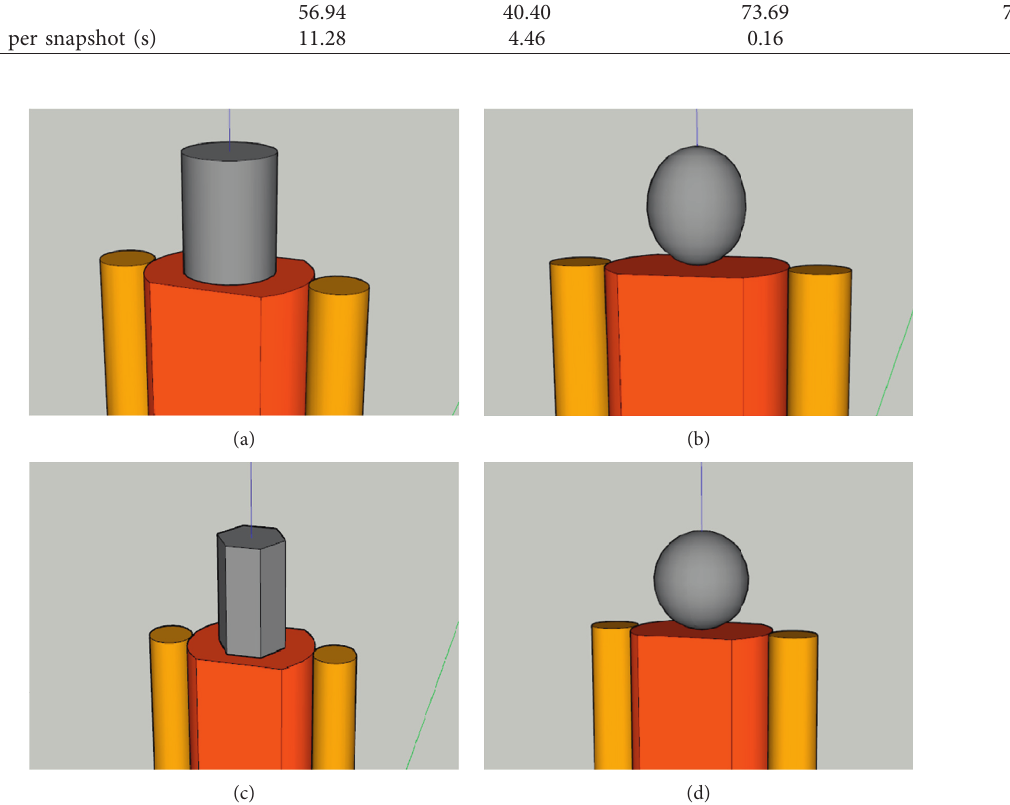
Figure 8: Four optional head shapes. (a) Cylinder. (b) Ellipsoid. (c) Prism. (d) Sphere.